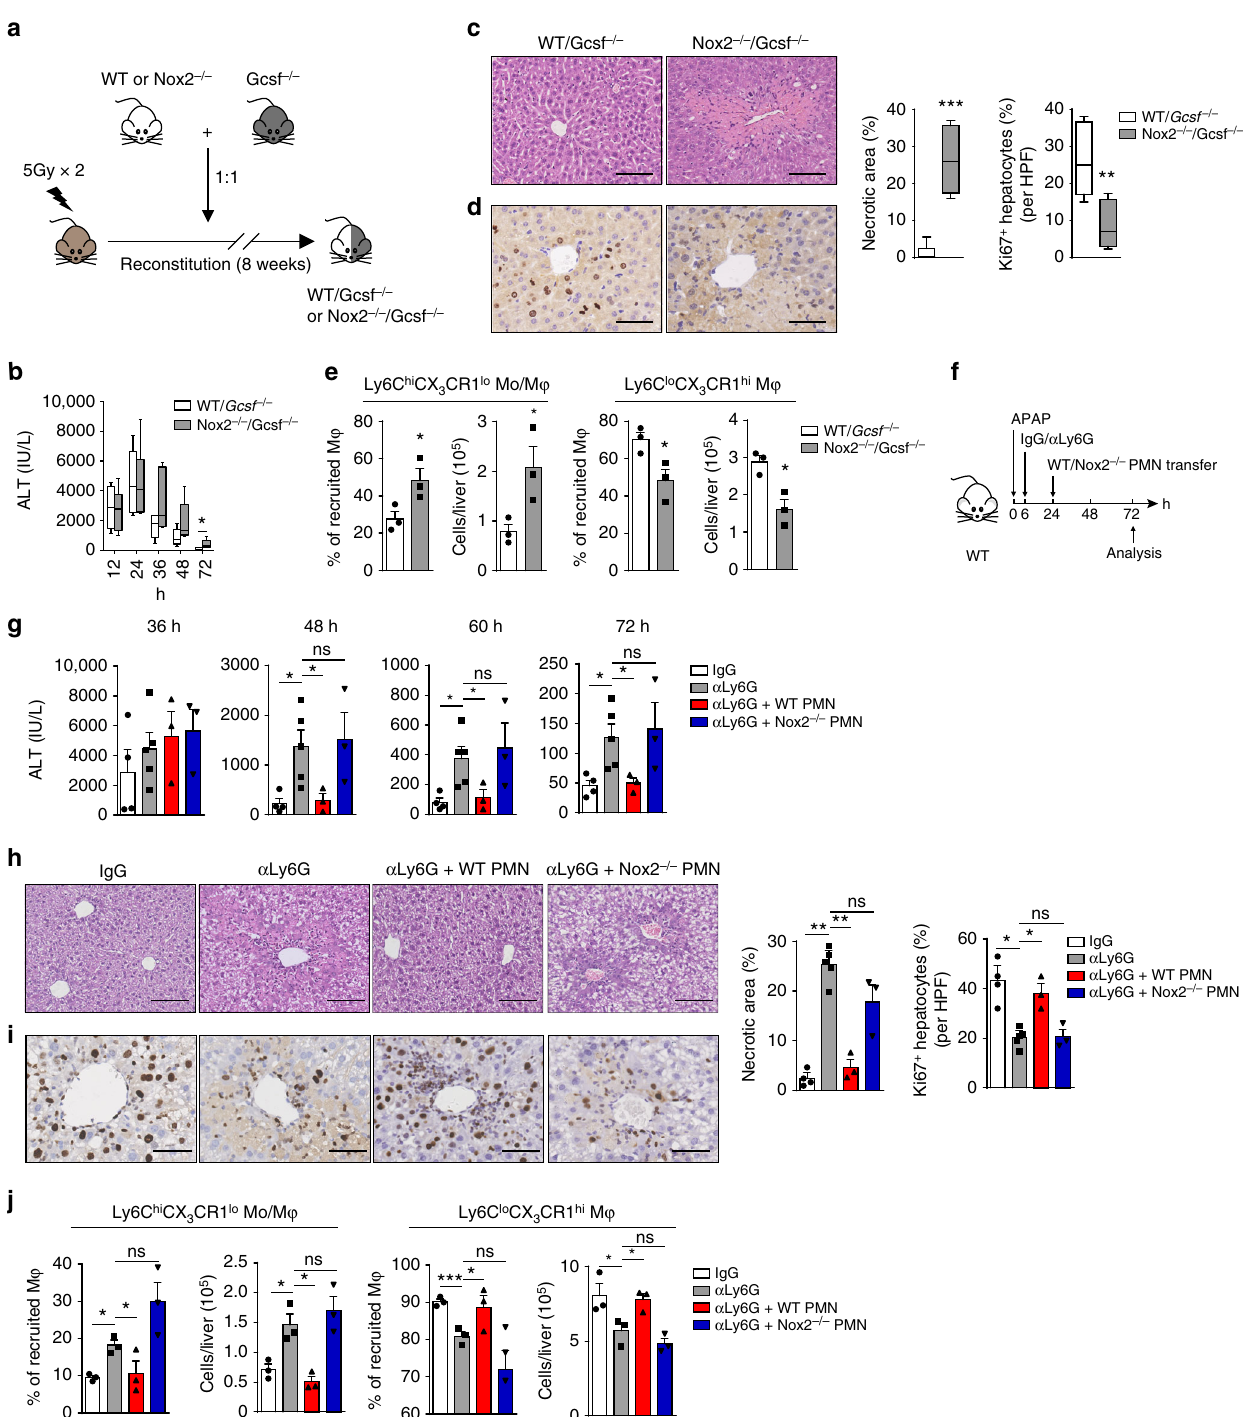
Fig. 4 ROS-producing neutrophils permit macrophage skewing toward a reparative phenotype. a – e Schematic of the experimental design: mixed bone marrow chimera mice were generated by reconstituting lethally irradiated WT recipients with 50% WT + 50% Gcsf − / − or 50% Nox2 − / − + 50% Gcsf − / − bone marrow cells (total transplanted cells were 10 7 cells per mouse) ( a ). Chimera mice were challenged with APAP. Serum ALT levels at the indicated time points ( b ), histological characterization ( c ), and IHC staining for Ki67 ( d ) in liver sections at 72 h were evaluated. n = 6. Whiskers show min to max. Bars show the median. The percentage and number of the indicated macrophage subsets at 72 h were calculated ( e ). n = 3. Experiment was repeated twice. f – j Schematic of the experimental design: WT mice were treated with neutrophil-depleting anti-Ly6G mAb at 6 h after APAP challenge; WT or Nox2 − / − neutrophils were adoptively transferred to the anti-Ly6G-treated mice at 24 h post APAP challenge ( f ). Serum ALT levels at the indicated time points ( g ), histological characterization ( h ), and IHC staining for Ki67 ( i ) in liver sections at 72 h were evaluated. n = 4, 5, 3, 3. The percentage and number of the indicated macrophage subsets at 72 h were calculated ( j ). n = 3. Experiment was repeated twice. The bar graph indicates 100 μ m ( c , h ), 50 μ m ( d , i ). The data shown are mean ± s.e.m. (* P < 0.05, ** P < 0.01, *** P < 0.001). P values were calculated by two-tailed Student ’ s t -test ( c – e , g – j